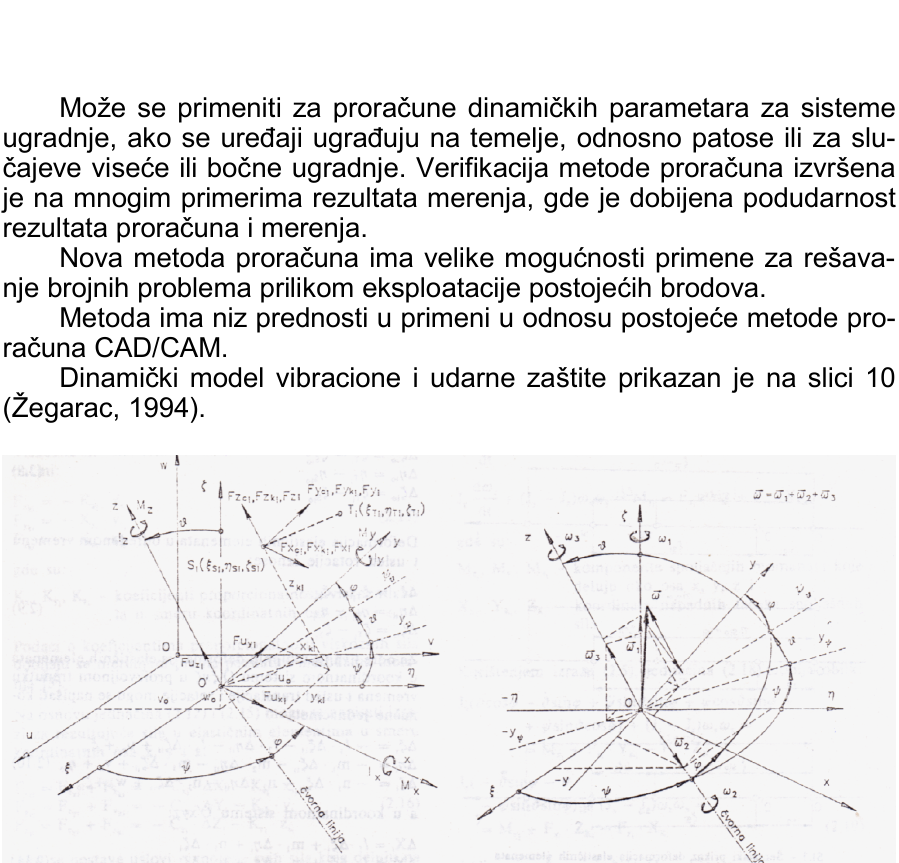
оборудования и механизмов Figure 10 – Dynamic model of the vibration and impact protection of power systems, devices and equipment Novi pogonski sistem radarske antene Na osnovu zahteva koji su postavili korisnici radarskih stanica, tre- balo je projektovati i osmisliti novi sistem pogona radarske antene, kako bi se postigao pouzdan rad i bezbednost vazdušnog saobra ć aja u siste- mu kontrole